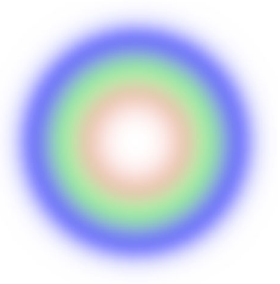
Fig. 8 Planar section depicting the contributions ρ 1 (red), ρ 2 (green) and ρ 3 (blue) to the total energy density for solutions of (18) with permeabilities given by (28). We depict the case n 1 = 2, n 2 = 8, n 3 = 10